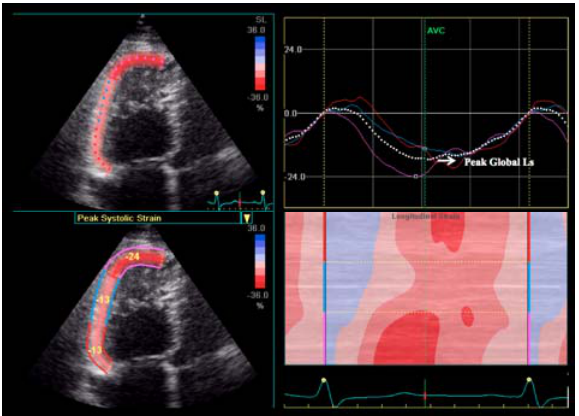
Figure 2. Right ventricular longitudinal strain impairment in pulmonary hypertension patient. Ls = longitudinal